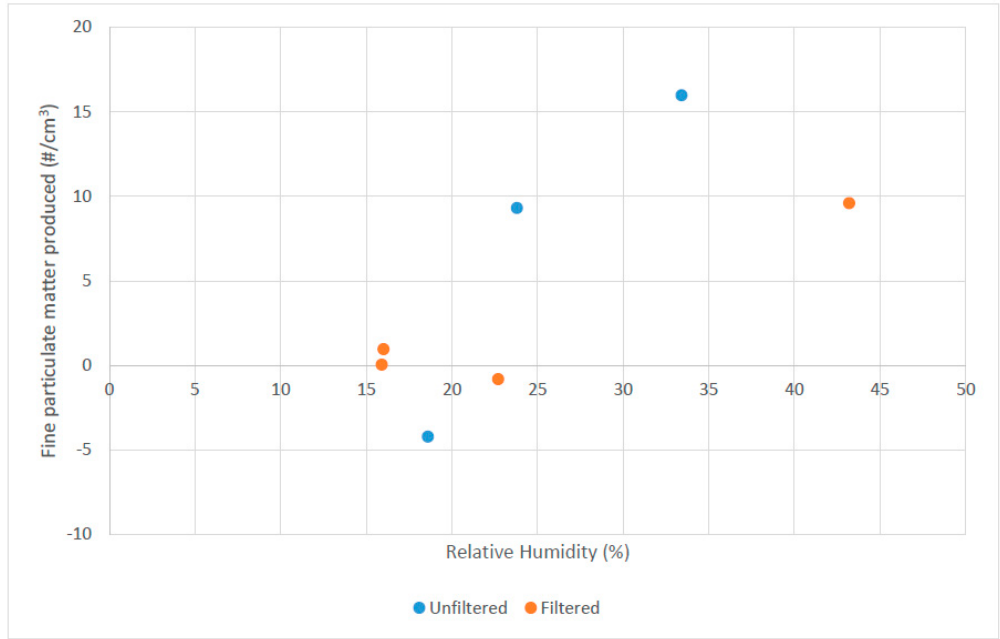
Figure 6. PM2.5 production for filtered and unfiltered room air at different relative humidities. Initial toluene concentration was between 55 and 85 mg/m 3 , with 5 min of UV exposure and 1 min of hold time before sampling. The initial particulate counts for unfiltered and filtered air were approximately 43 × 10 6 and 5 × 10 6 particles/m 3 ,